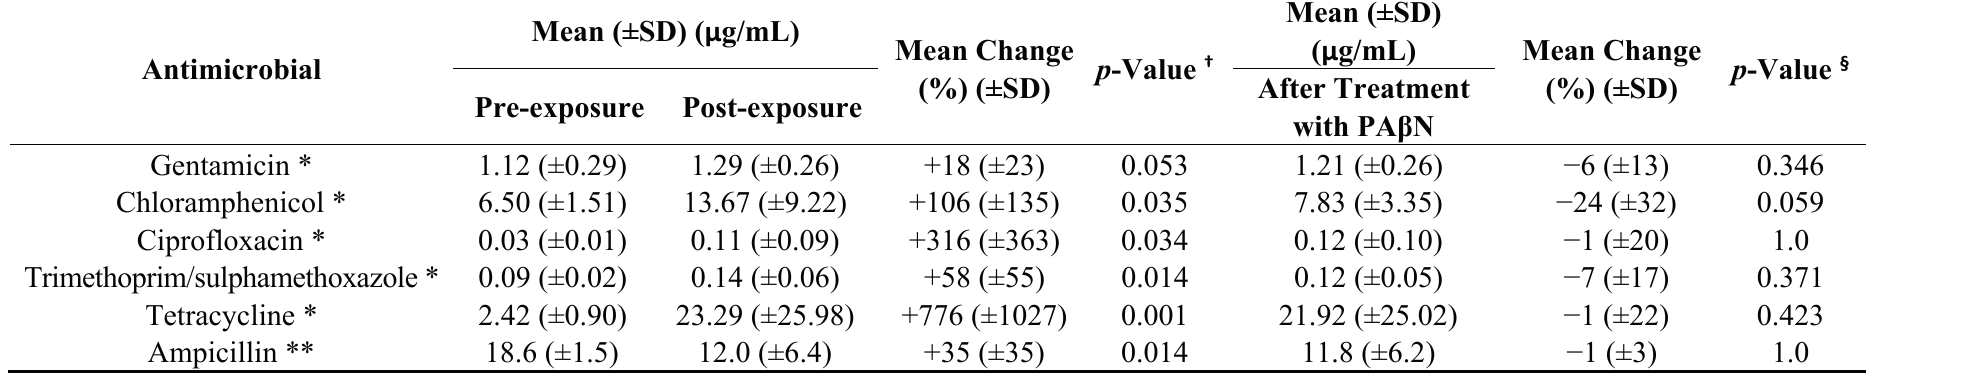
Table 2. MIC against studied strains for gentamicin, chloramphenicol, ciprofloxacin, trimethoprim/sulphamethoxazole, and tetracycline; zone inhibition diameter for ampicillin before exposure to Product A, after exposure to Product A, and after treatment with efflux pump inhibitor (PA β N). The p -values were obtained using paired Wilcoxon tests for the comparisons: † before and after exposure to Product A; § after exposure to Product A and after treatment with efflux pump